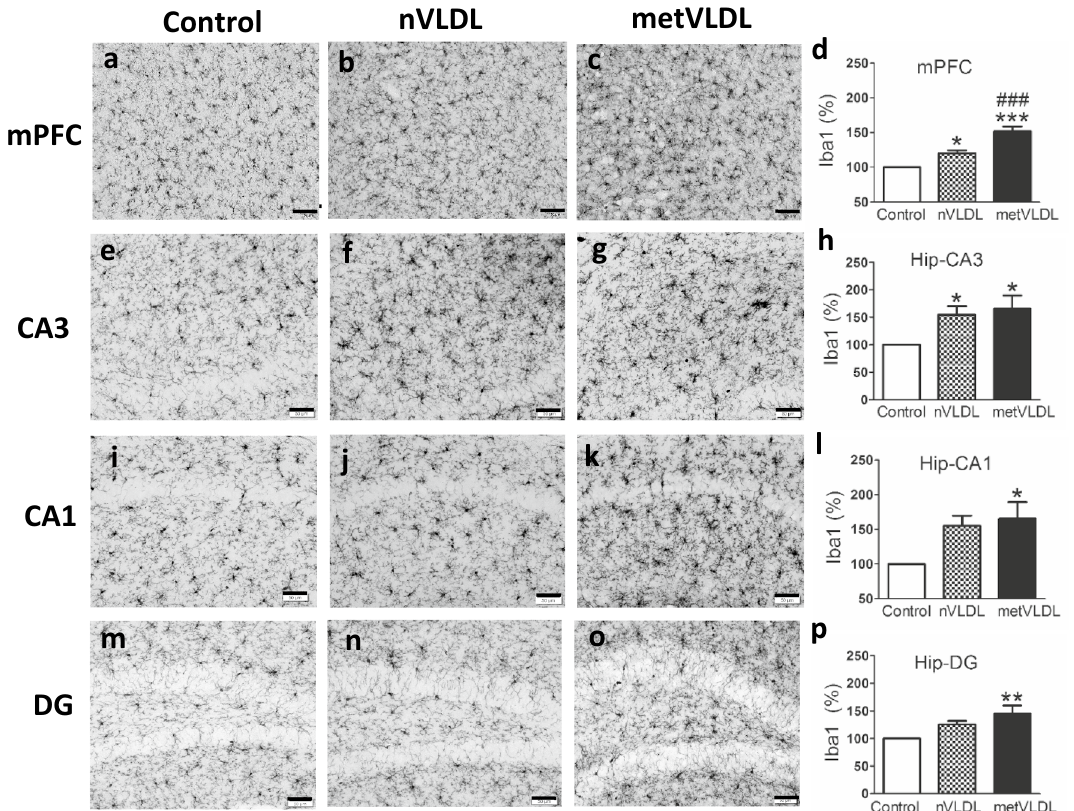
Figure 3. Immunostaining showing the expression of Iba1 (microglia) in the medial prefrontal cortex (mPFC) and hippocampus CA3, CA1, and dentate gyrus (DG) of mice after 6 weeks of tail-vein injections with saline (control: a , e , i , m ), 15 μg/g nVLDL ( b , f , j , n ), or 15 μg/g metVLDL ( c , g , k , o ). Magnification = 20X; scale bar = 50 μm. The percentage of Iba1 immunostaining (%) in mPFC ( d ), CA3 ( h ), CA1 ( l ), and DG ( p ), calculated by using cellSens Dimension software (version 1.13, Olympus), is compared among groups (n ≥ 7 in each group). Data are presented as the mean ± standard error of the mean. *p < 0.05, **p < 0.01, ***p < 0.001 vs. control. ###p < 0.001, nVLDL vs. metVLDL. P-values were determined by using one-way analysis of variance with the Newman-Keuls post-hoc